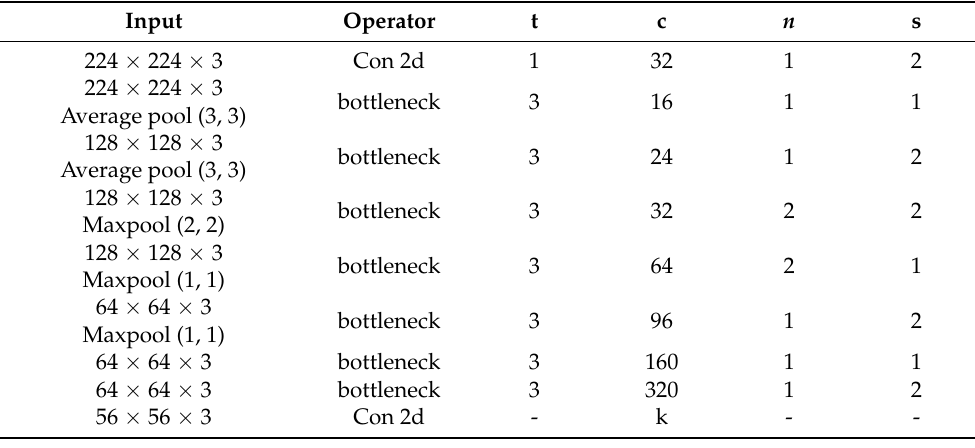
Table 4. Layers of modified MobileNetV2 Architecture.